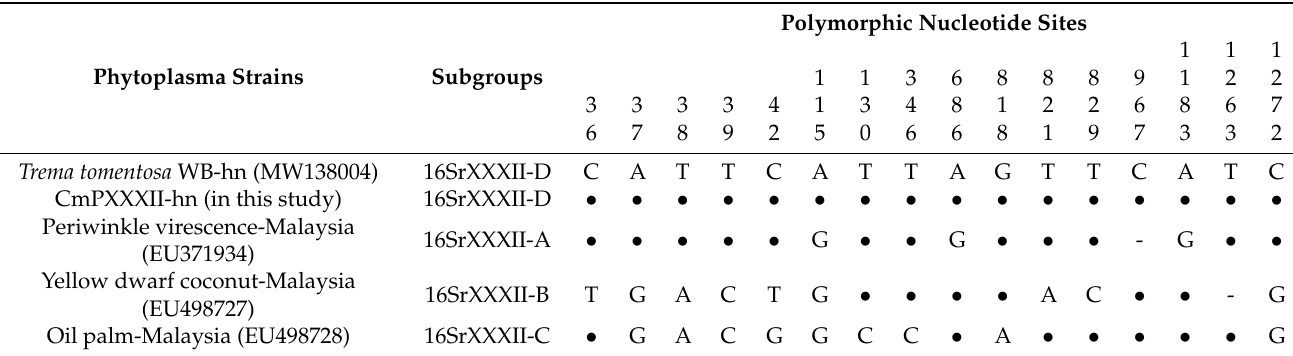
Table 1. Polymorphic nucleotide sites in the 16S rRNA gene fragments of the phytoplasma strains belonging to the 16SrXXXII